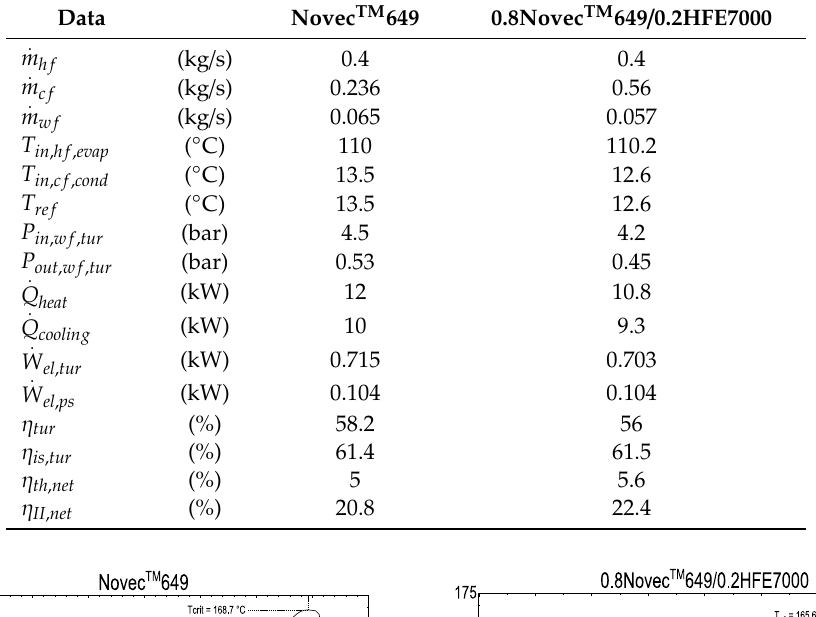
Table 4. The calculated data for the optimized highest points.